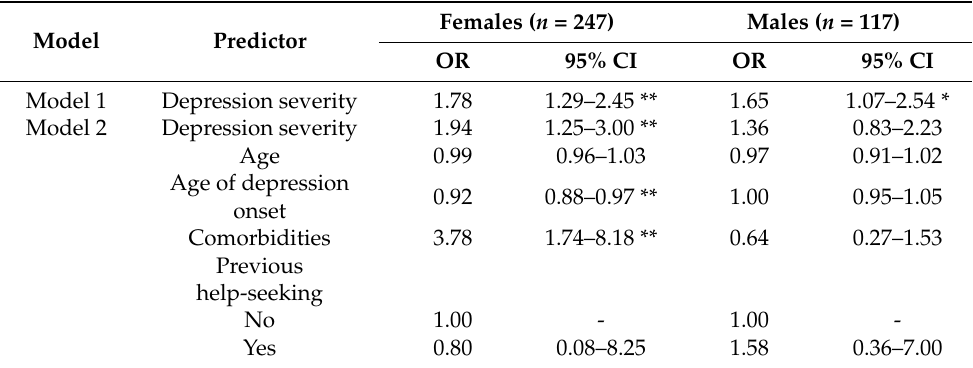
Table 3. Regression for suicide attempt.